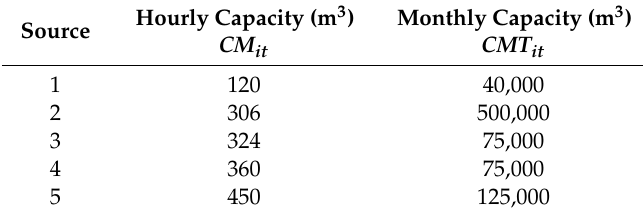
Table 4. Maximum supply capacity of each source.